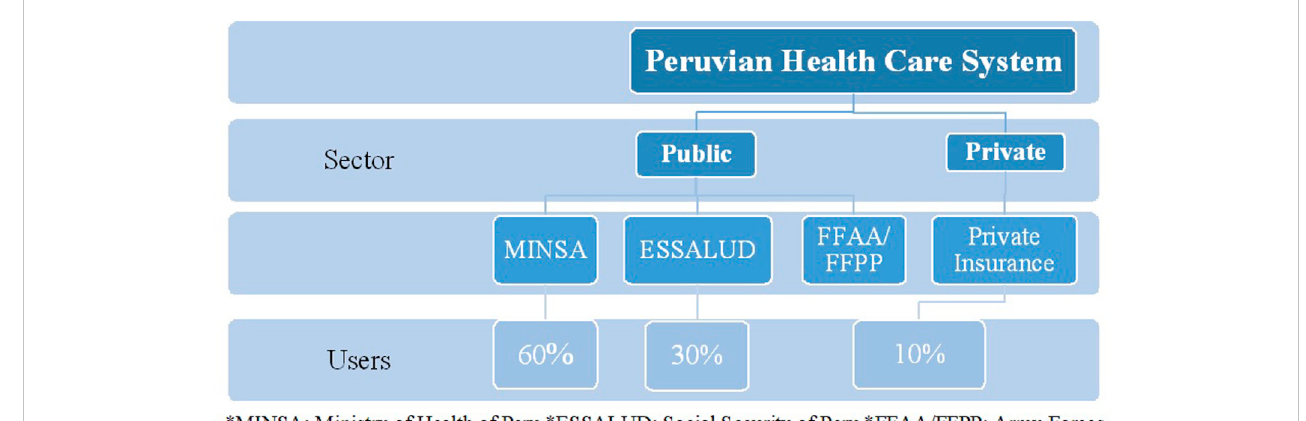
FIGURE 1 Peruvian Healthcare System Structure. *MINSA, Ministry of Health of Peru; *ESSALUD, Social Security of Peru; *FFAA/FFPP, Army